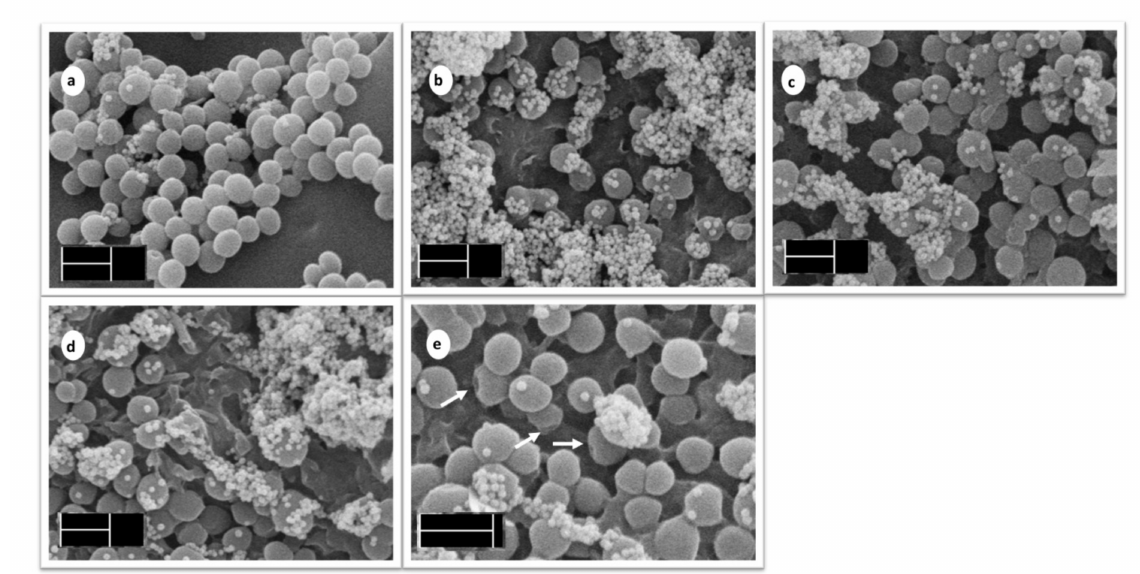
Figure 9. Effectiveness of photodynamic inactivation on MRSA strain S. aureus L18. SEM microphotographs are as follows: the 24 h biofilm of S. aureus L18 on PU ( a ); PUC ( b ); PhB/PUC ( c ); irradiated PhB/PUC ( d ); detail of biofilm cells on irradiated PhB/PUC ( e ). The magnification was 20,000 × (scale 1 µ m) for micrographs labeled ( a – d ), and 30,000 × (scale 1 µ m) for micrograph labeled ( e